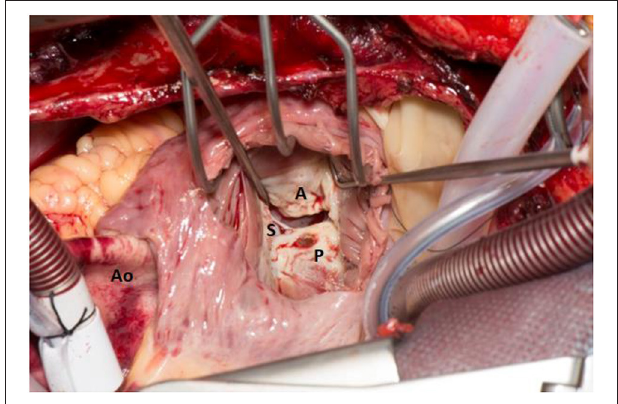
FIGURE 1 | The right atrium is opened and retracted exposing the Tricuspid Valve (TV). The cardiopulmonary bypass caval cannulae can be seen. The Aorta (Ao) is on the left hand side. The TV can be seen through the right atrium and the leaflets are labeled respectively (anterior leaflet- A, posterior leaflet- P and septal leaflet- S). The leaflets are thickened and fibrosed and the septal leaflet is plastered onto the ventricular septum